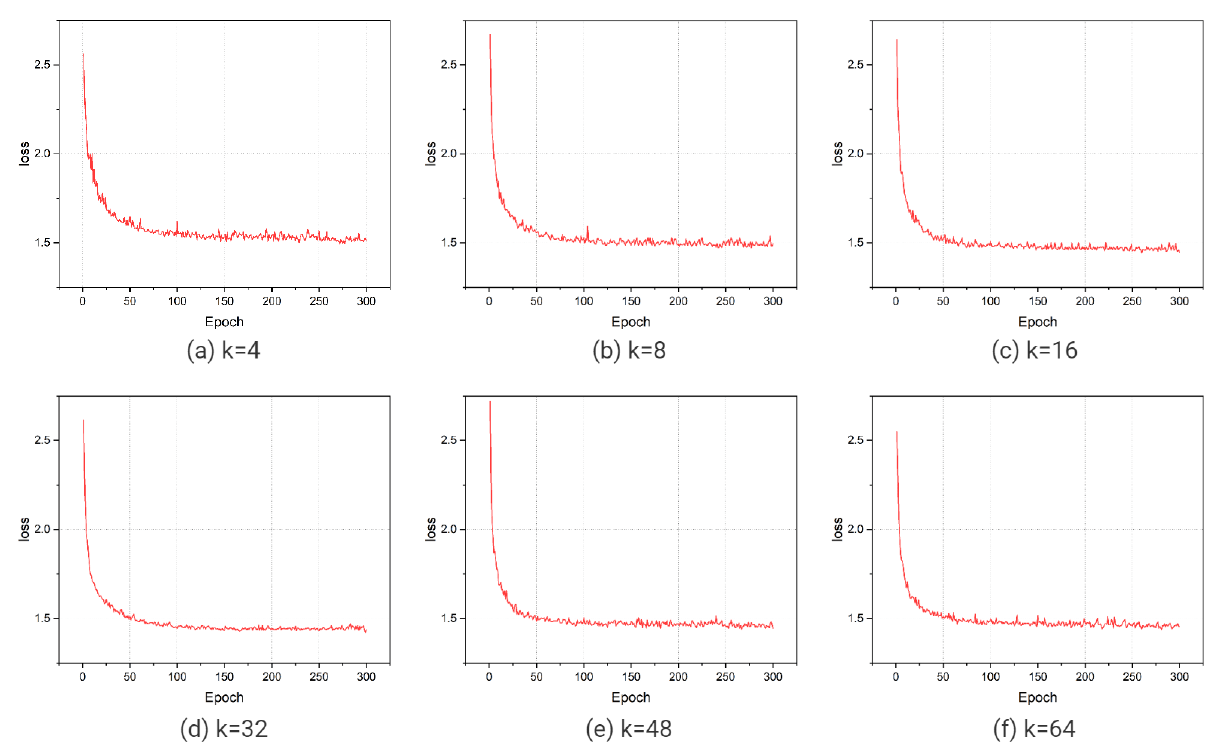
Figure 6. The loss of TR-Net with different neighbors during each testing phase.